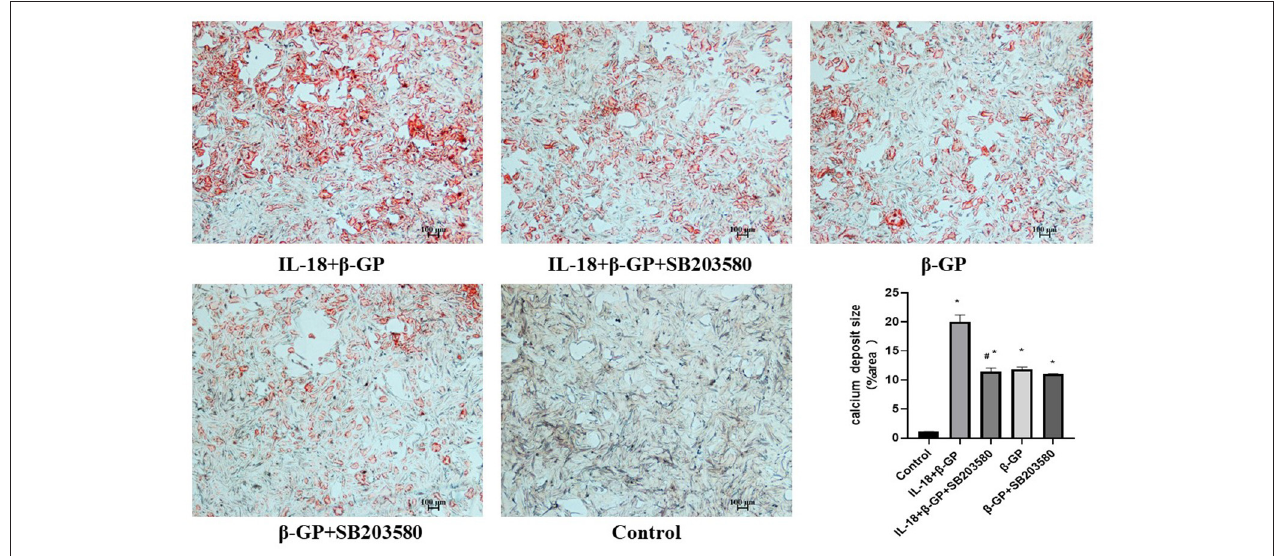
FIGURE 11 | Alizarin red staining of VSMCs. Effect of p38 pathway on IL-18-induced calcium deposition of rat VSMCs. Rat VSMCs were pre-incubated with p38 inhibitor SB203580 (10 µ mol/L) for 2h, and then treated with β -GP (10 mmol/L) or IL-18 (100ng/ml) + β -GP (10 mmol/L) for 14 days, respectively. The experiment